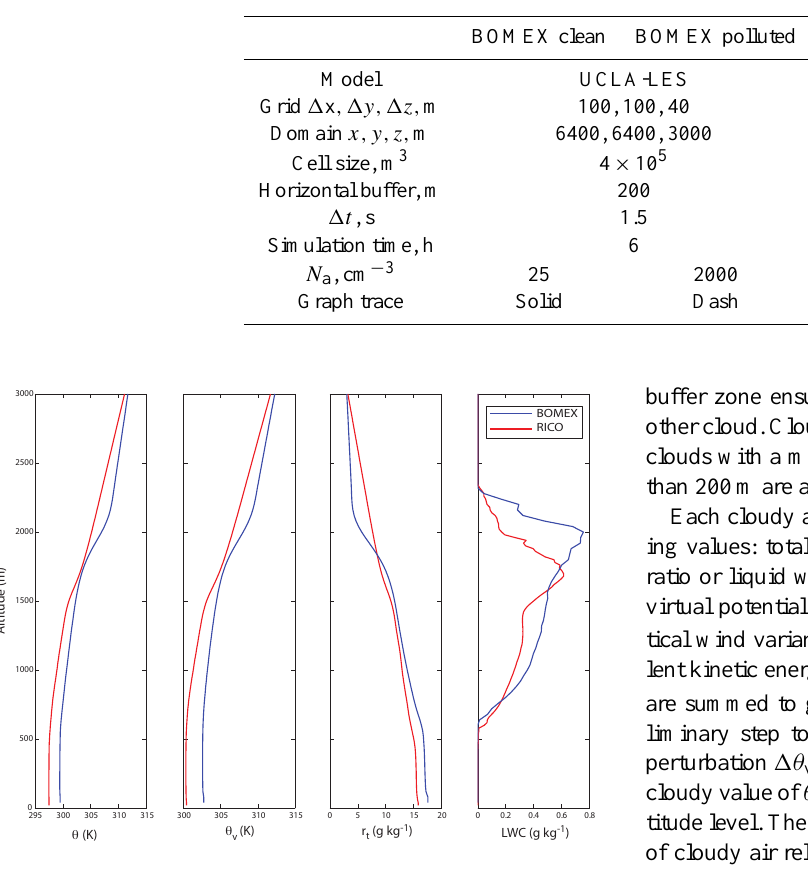
Table 1. Model details.